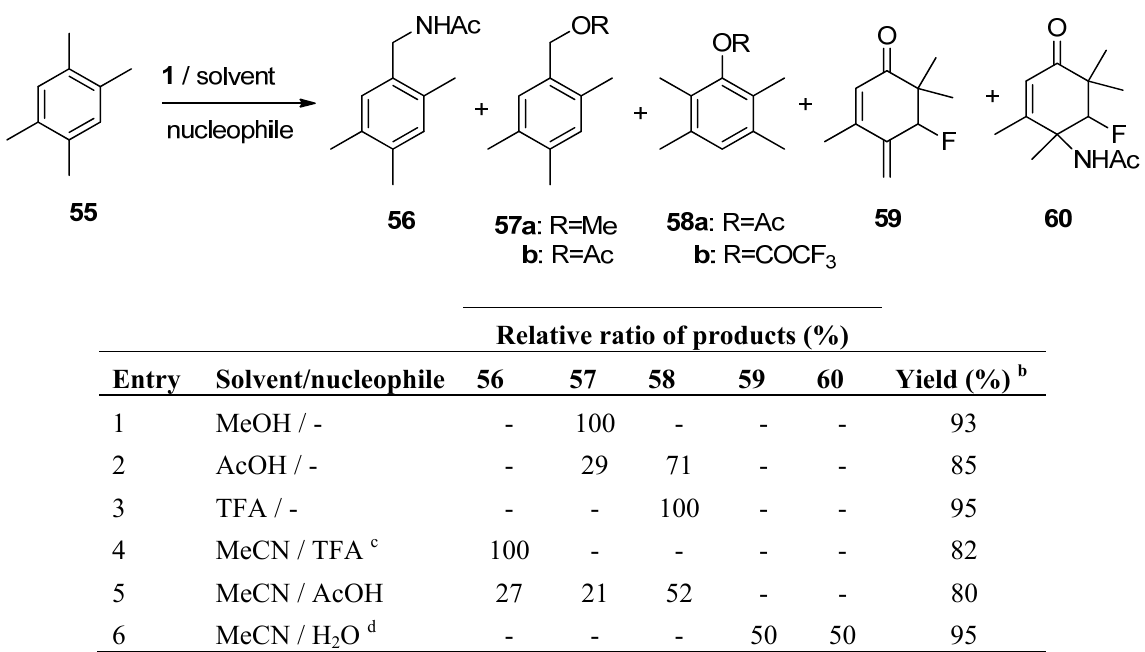
Table 5. Effect of solvent and external nucleophile on the transformation of 1,2,4,5- tetramethyl benzene with F-TEDA-BF